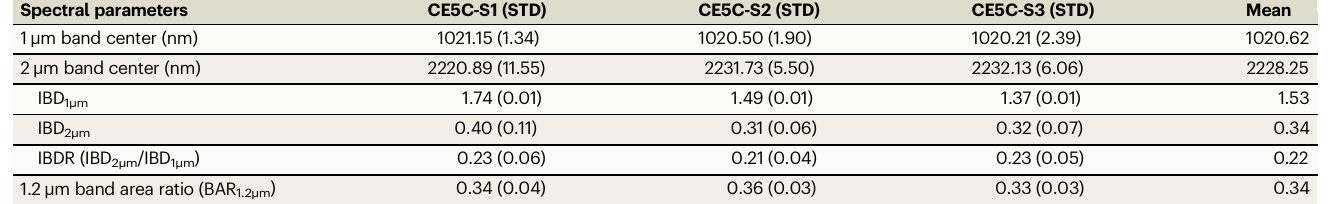
Table 1 | Spectral parameters of the three CE-5 soil samples Spectral parameters